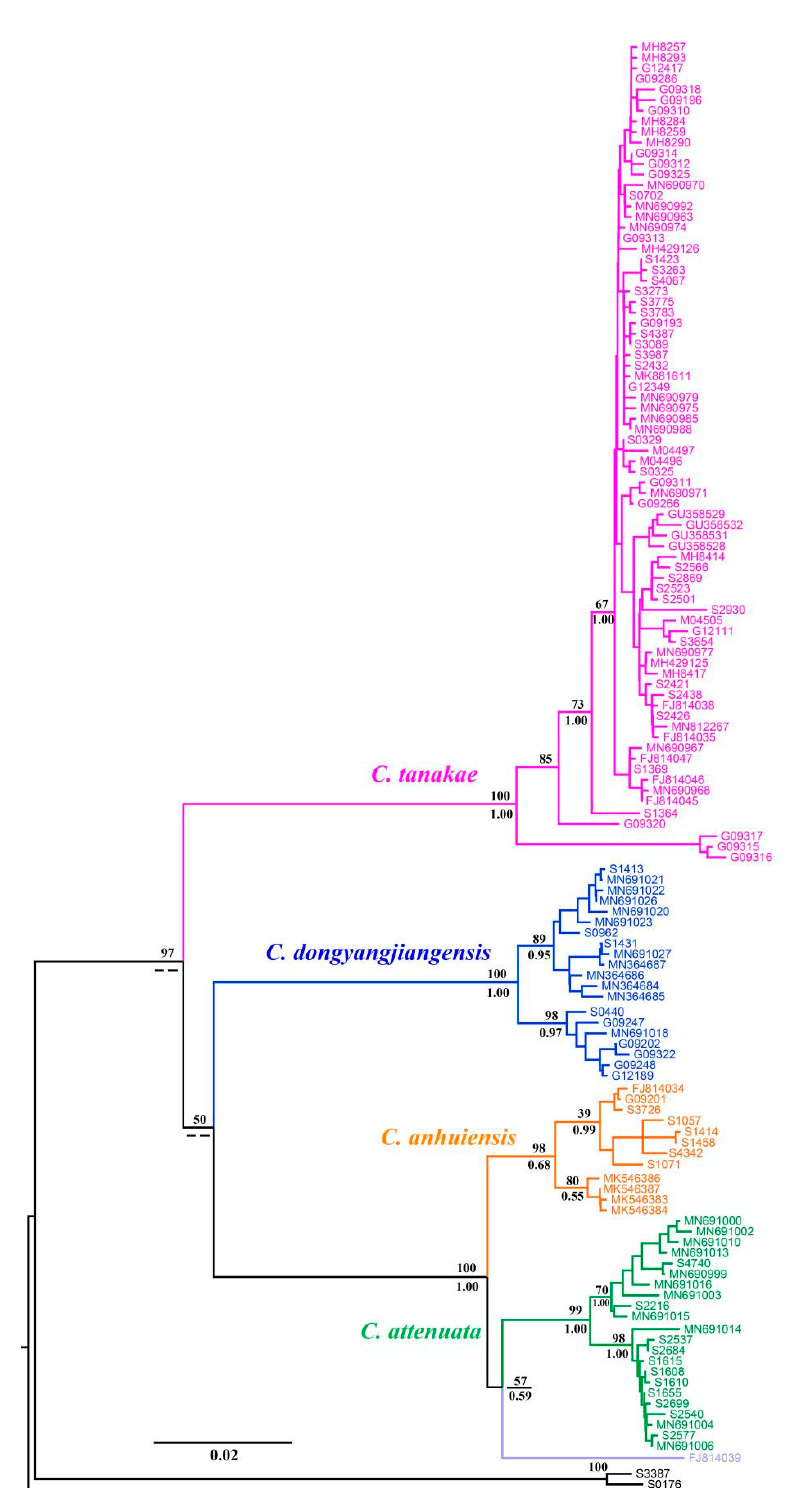
Figure 2. Phylogenetic tree of C. attenuata species complex based on Cytb gene. Numbers above and below branches represent bootstrap support (BS) of ML and posterior probabilities (PP) of BI, re- spectively.